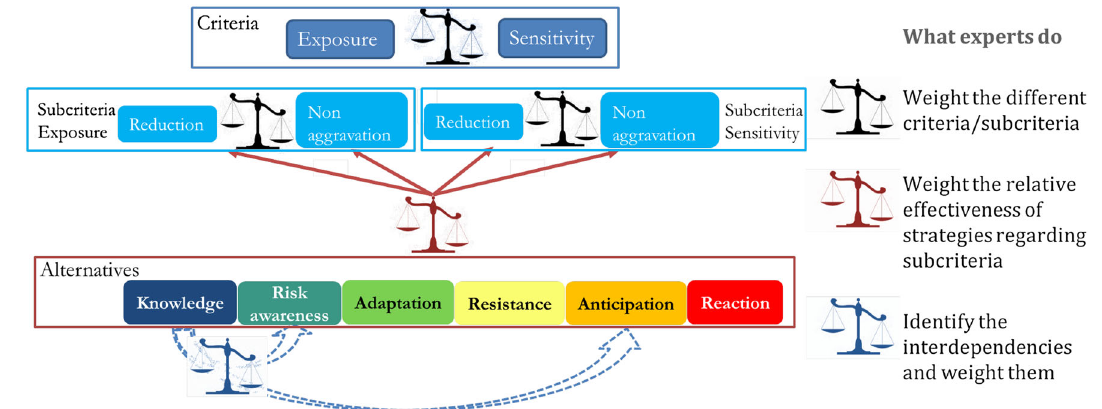
Fig. 3 The analytic network process model to weight the six strategies